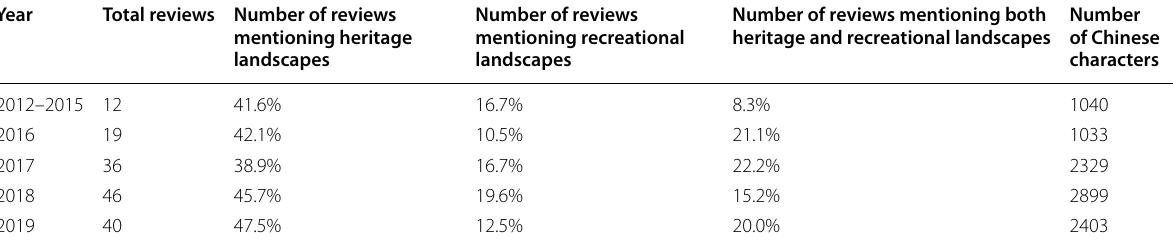
Table 7 Tourist reviews of Guangfu Ancient City from Mafengwo travel website